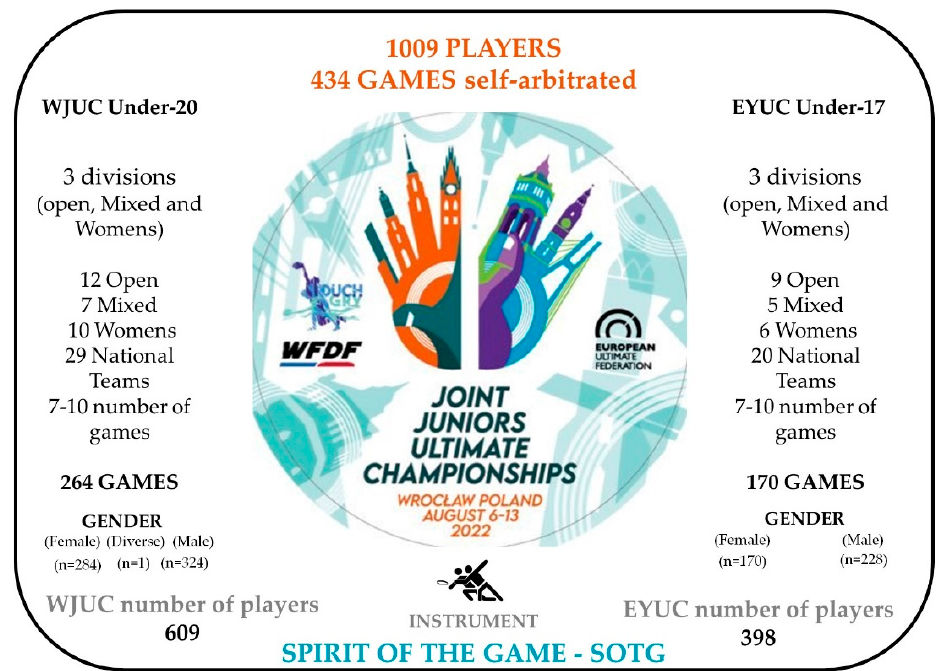
Figure 1. Joint Junior Ultimate Championship description, and their respective divisions: in 2022, the World and European Youth Championship were hold together in Wroclaw, Poland. A total of 434 self-refereed games were played with 1009 participating players altogether. Teams competed in three divisions, Open, Mixed, and Women’s. After each game, the teams evaluated the opponent team’s knowledge of the rules, body contact avoidance, attitude, communication, and fair- mindedness during their game. These are the main aspects of the spirit of the game.